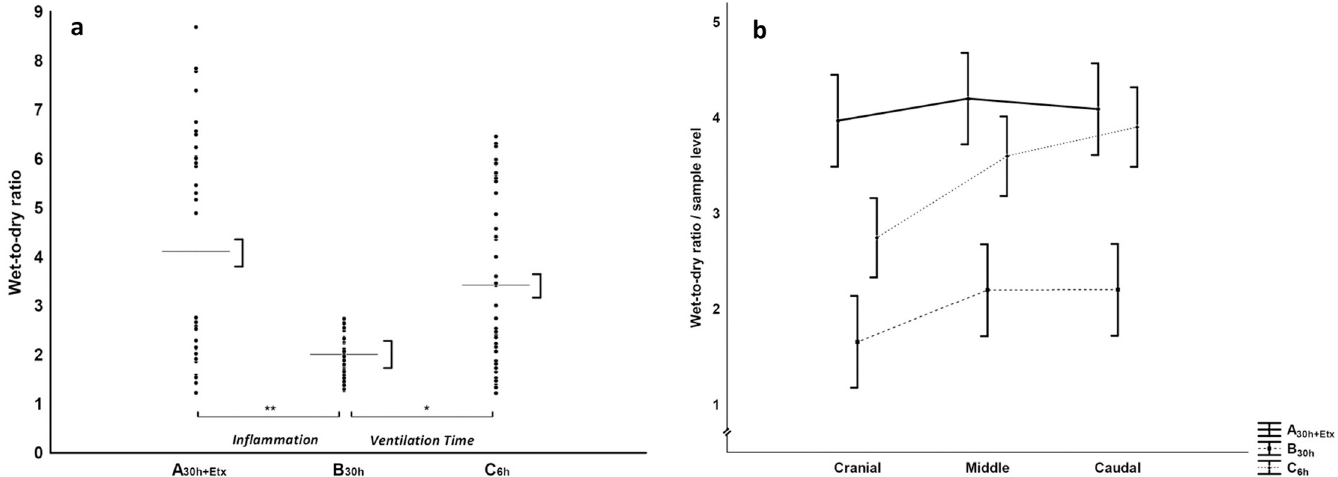
Fig 3. Wet-to-dry weight ratio of lung tissue. Wet-to-dry ratios of lung tissue. a) Dots represent raw data for each group, mean ± SEM (line, brackets), general linear model, experimental parts Inflammation A